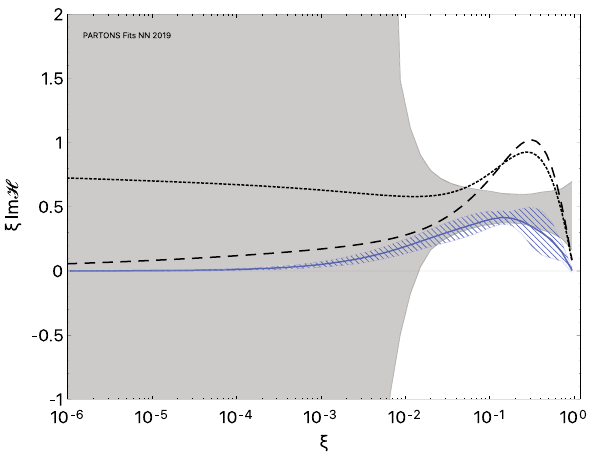
Fig. 20 The same as Fig. 16, but without the HERA and COMPASS data taken into account in the extraction of